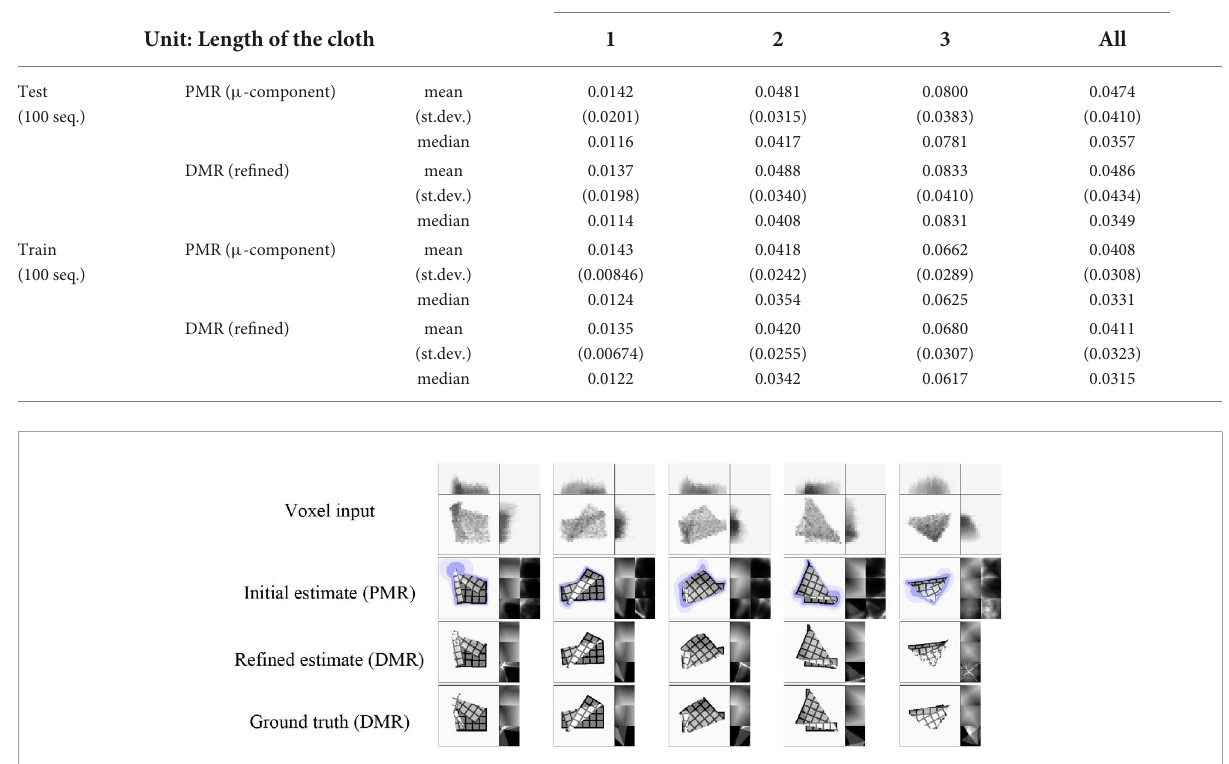
FIGURE6 Representative examples of shape estimation and refinement (test set data). Each column represents one example. The last example shows a case where the z-ordering of the cloth layers is particularly difficult to infer from the voxel representation, leading to ambiguous z-ordering in the